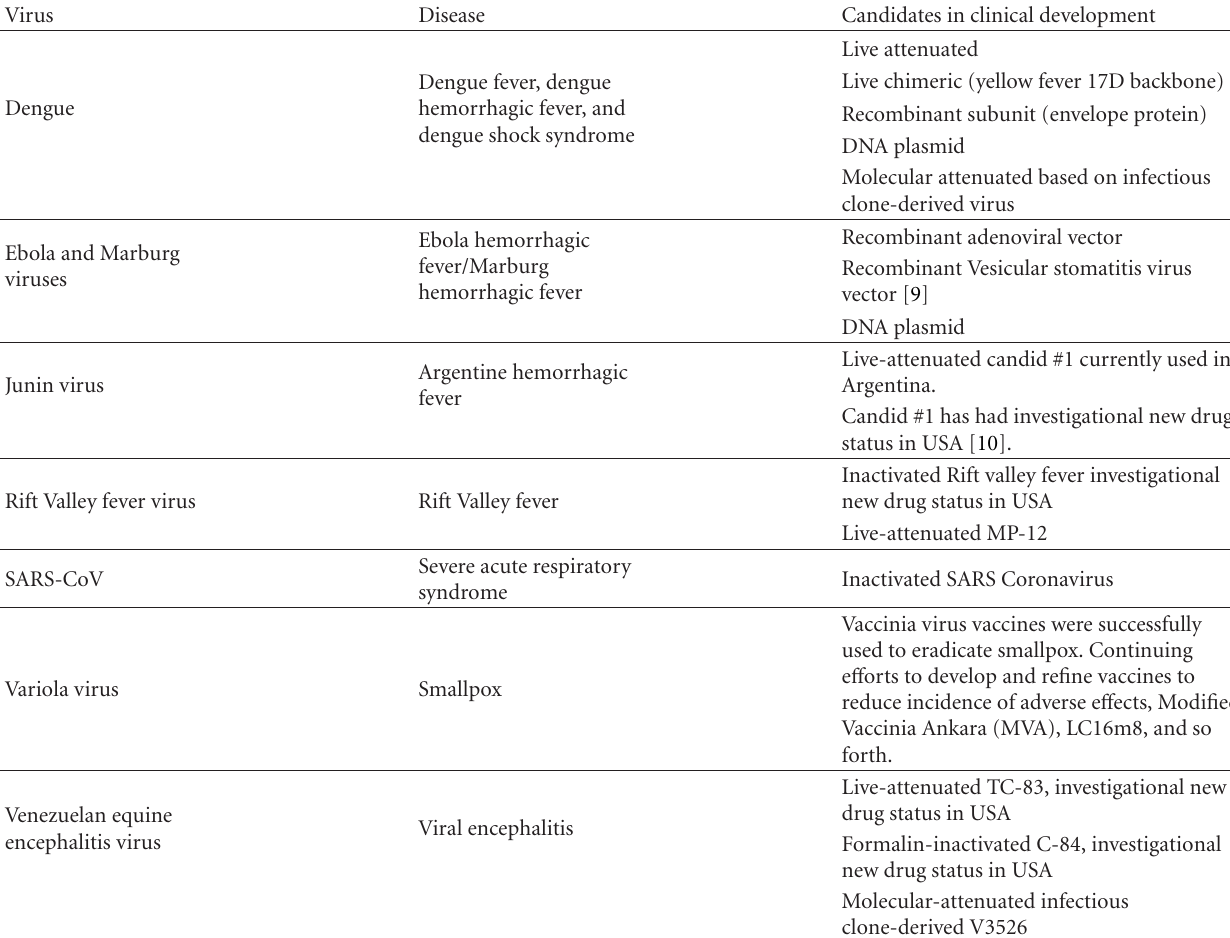
Table 1: Current status of vaccines in clinical trials against priority pathogens and potential biothreat agents. Data for the table come from http://www.clinicaltrials.gov/ and other sources as indicated. Many vaccines are in preclinical development, including a number of candidate vaccines for Lassa virus [1–6] and Sin Nombre [7, 8] virus, both being important hemorrhagic fever